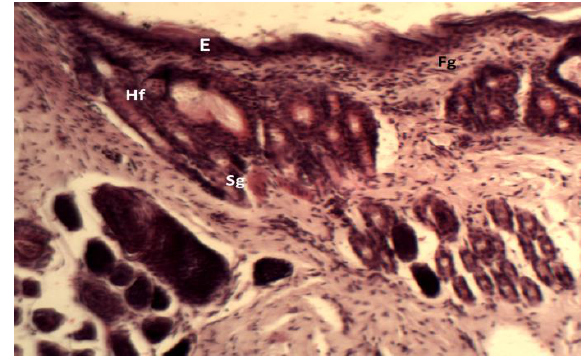
Figure, 21: Section of skin (28 days post treatment with pericardial membrane) shows epidermis (E) much of hair follicles